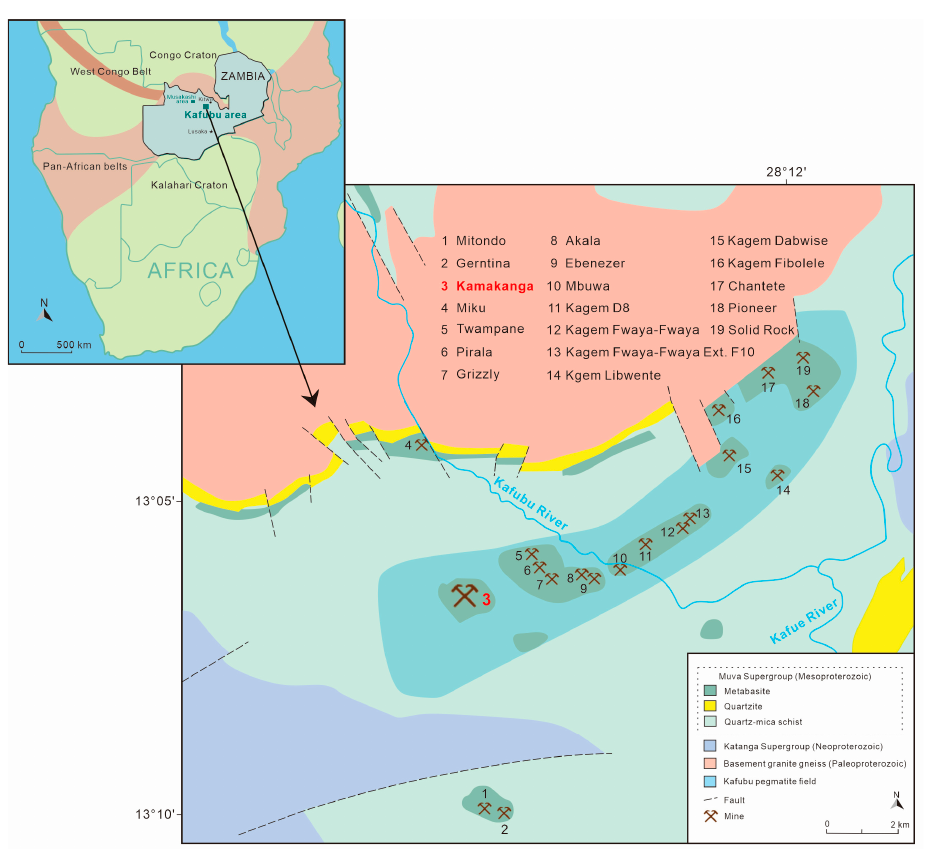
Figure 1. Simplified geological map of the Kafubu area, including the location of the Kamakanga deposit in this area. Modified from [2].